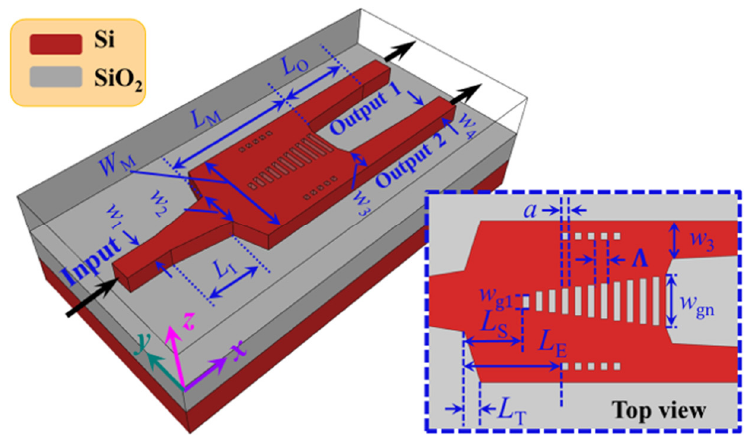
Figure 1. Schematic of our proposed power splitter based on SWG-assisted MMI structure, where an inverse-tapered SWG and two rows of uniform SWG slots were embedded in the center and on both sides of the MMI waveguide respectively. The inset shows the top view of the key MMI region in detail. The material and structural parameters are also labeled.